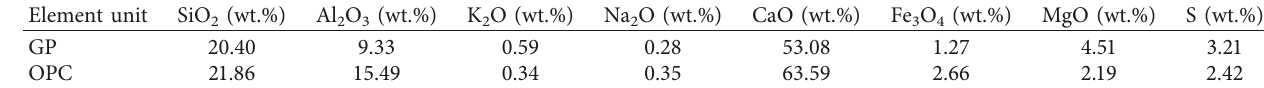
Table 1: Main chemical constituents of the materials.